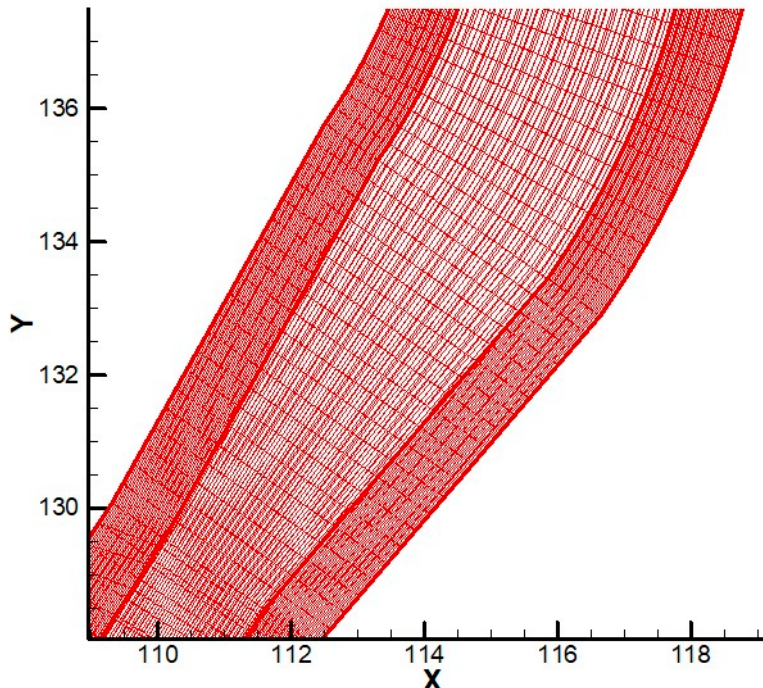
Figure A6. Close-up plan view of the highest density 3D mesh (492 × 42 × 32) along the straight transition reach between the two channel curves.